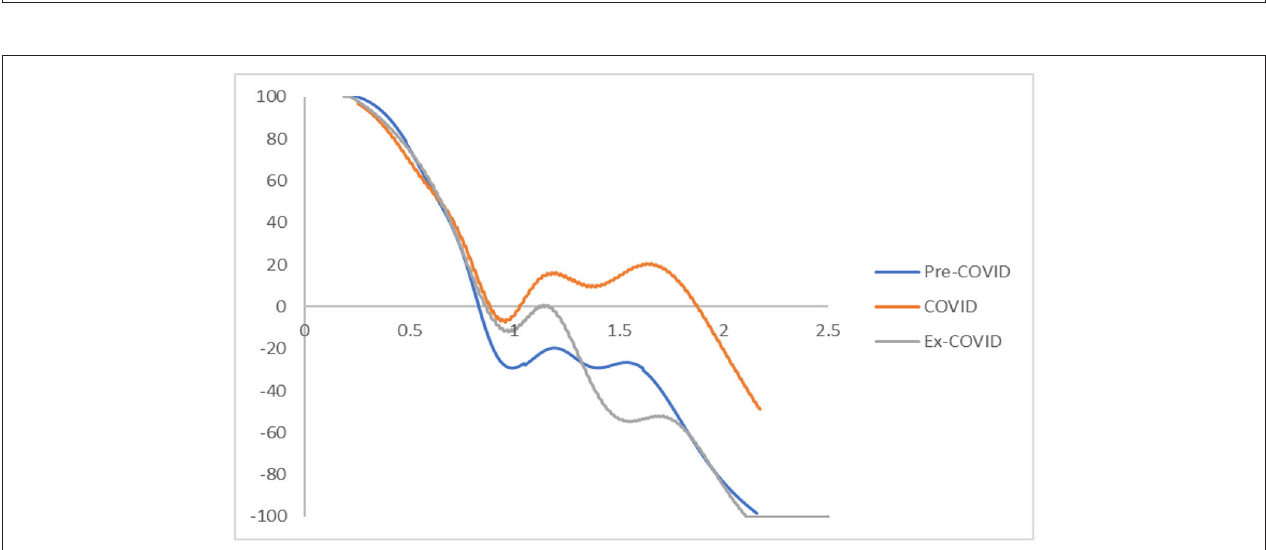
FIGURE 5 | Mobility probability plot (MPP) for the RDIPC of all residents in cities with medium duration of Level I ERS with quarterly transitions. Source: authors’ calculation. N.B. The vertical axis indicates net upward mobility (%) and the horizontal axis indicates RDIPC values.